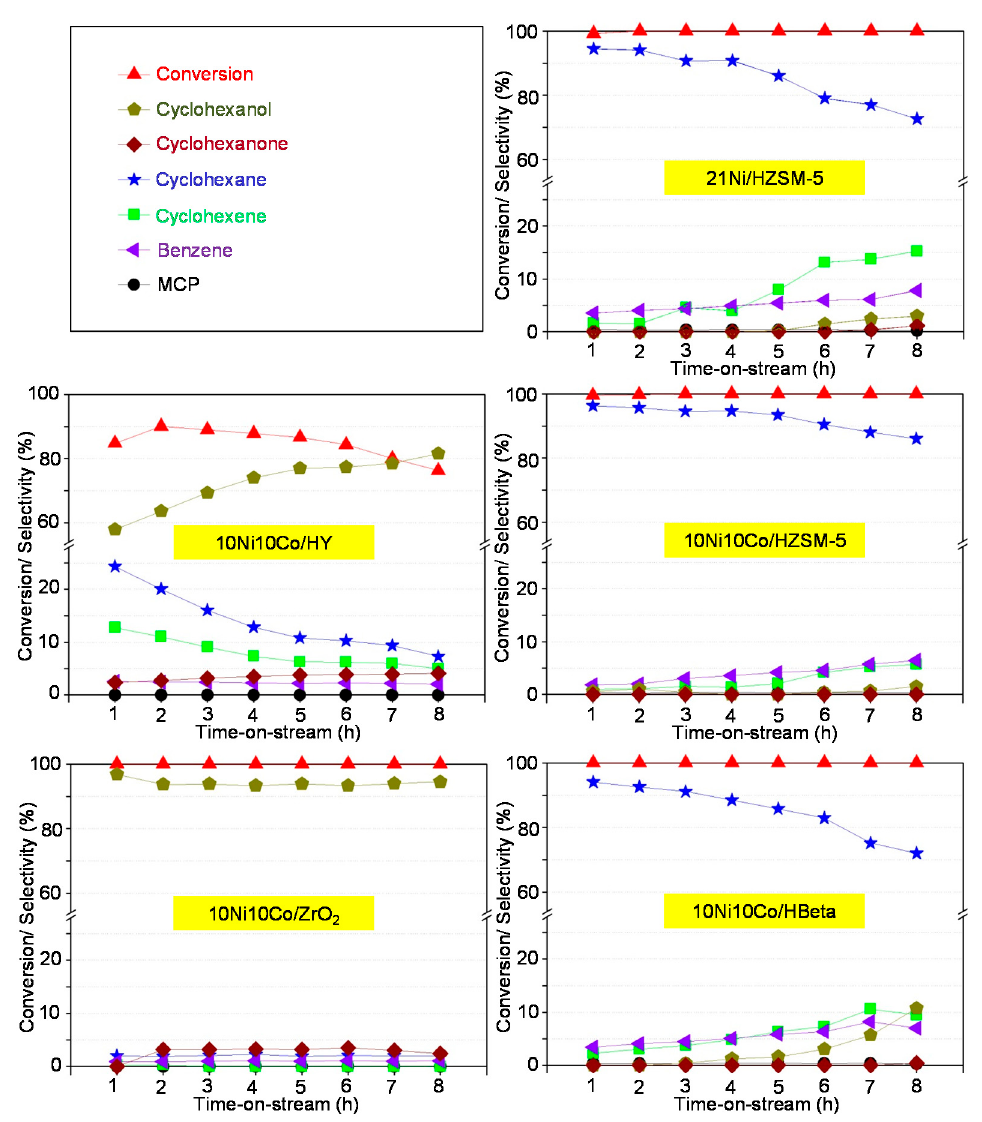
Figure 1. Phenol hydrodeoxygenation (HDO) over various catalysts in the continuous reactor ( T = 250 °C, 60 bar H 2 , weight hourly space velocity (WHSV) = 1.8 h − 1 , 3 wt % phenol in H 2 O, H 2 : phenol molar ratio = 28).